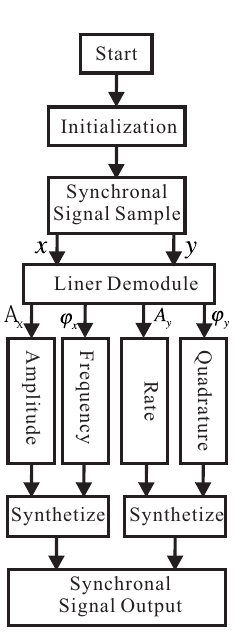
Figure 15. The flow of the control